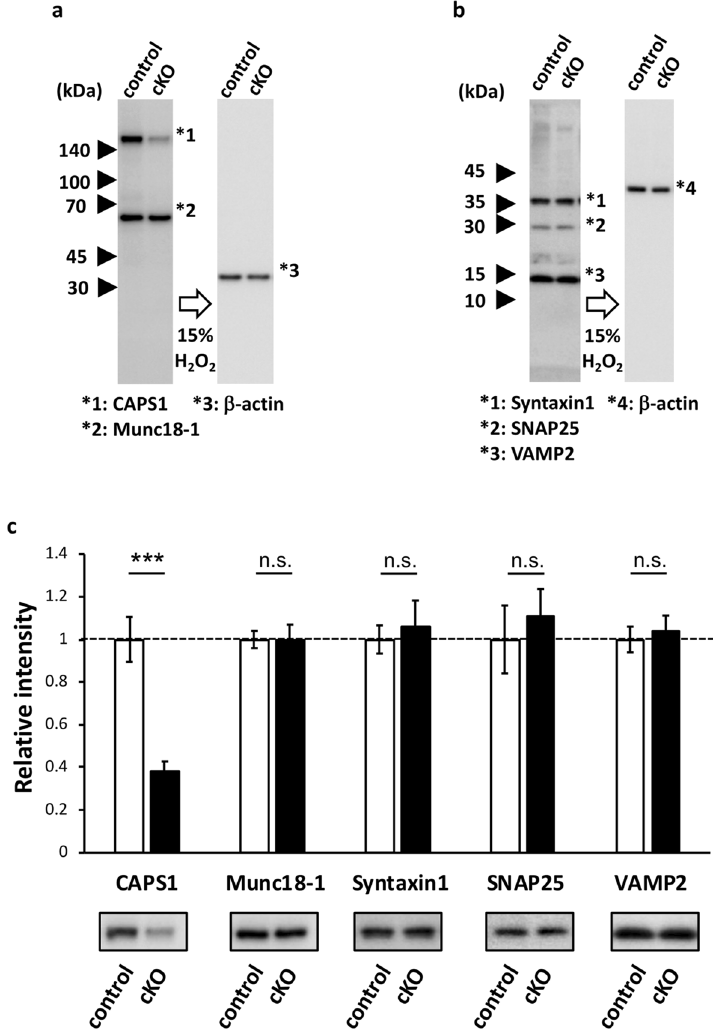
Figure 1. Expression levels of presynaptic proteins that contribute to SV release in the Caps1 cKO hippocampus. ( a ) Representative Western blot images of CAPS1 and Munc18-1. Synaptosomal fractions were prepared from hippocampal tissue homogenates (1 µg of total protein per lane). CAPS1, and Munc18-1 were detected on the same membrane. β-actin was used as an internal control to normalize the expression levels of each protein after treatment with 15% H 2 O 2 . ( b ) Representative Western blot images of syntaxin-1, SNA25, and synaptobrevin/VAMP2. Synaptosomal fractions were prepared from hippocampal tissue homogenates (1 µg of total protein per lane). Syntaxin-1, SNA25, and synaptobrevin/VAMP2 were detected on the same membrane. β-actin was used as an internal control to normalize the expression levels of each protein after treatment with 15% H 2 O 2 . ( d ) Expression levels of presynaptic proteins in control and Caps1 cKO hippocampal synapses. An image of a representative band is depicted below the corresponding bar graph. The expression level of each protein in Caps1 cKO hippocampi was standardized to that of control hippocampi. The blots in Fig. 1 were cropped from the same parts of the same gels as shown in Supplementary Figure S1. ( a , b ) were from Figure S1b and ( a ), respectively. Similarly, the blots in ( d ) were also derived from the corresponding blots shown in Supplementary Figure S1. Control, n = 6 animals; Caps1 cKO, n = 6 animals. P = 0.974, 0.700, 0.601 and 0.682 for Munc18, Syntaxin1, Smap25 and VAMP2, respectively, Student’s t